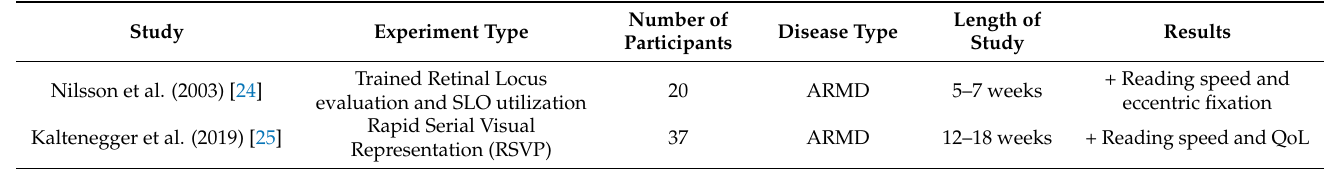
Table 2. Outline of the different studies